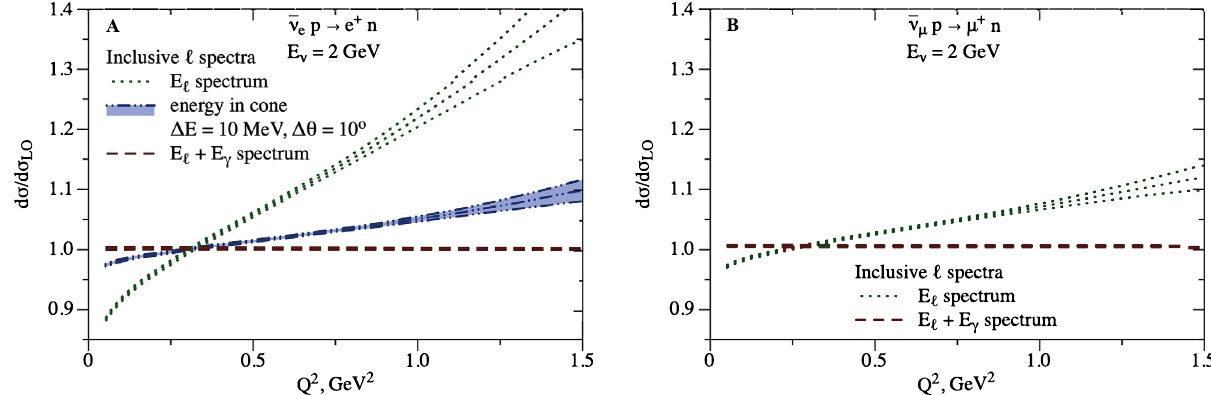
Fig.5|Radiativelycorrectedcross-sectionratiotothetree-levelresultandcorrespondinguncertaintyinantineutrinoscatteringforinclusiveobservables. Same as Fig. 4 but for antineutrino